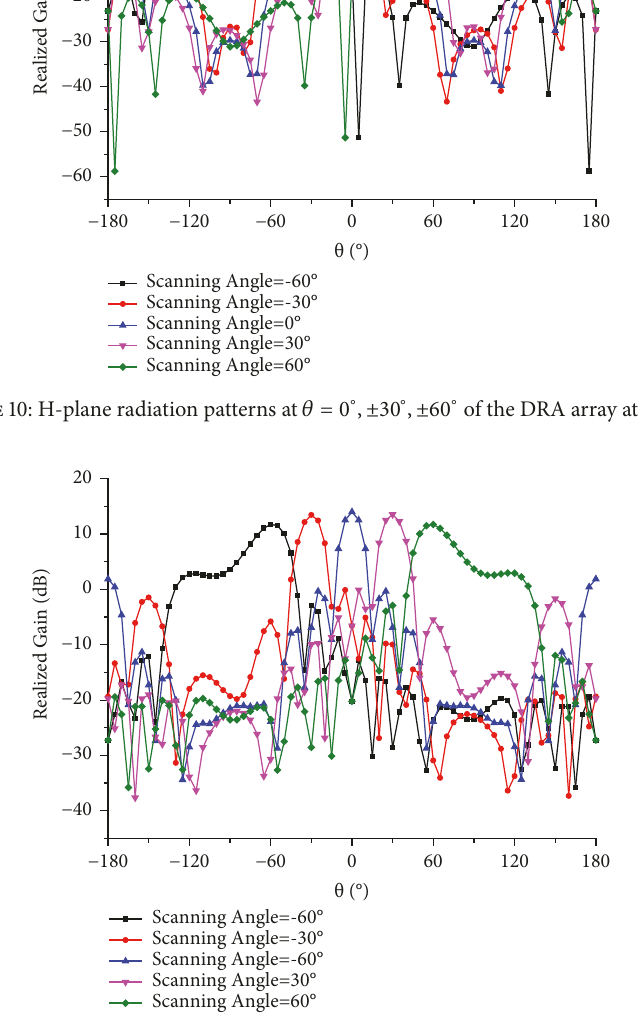
is All Purpose AA Extra-glue produced by ARON